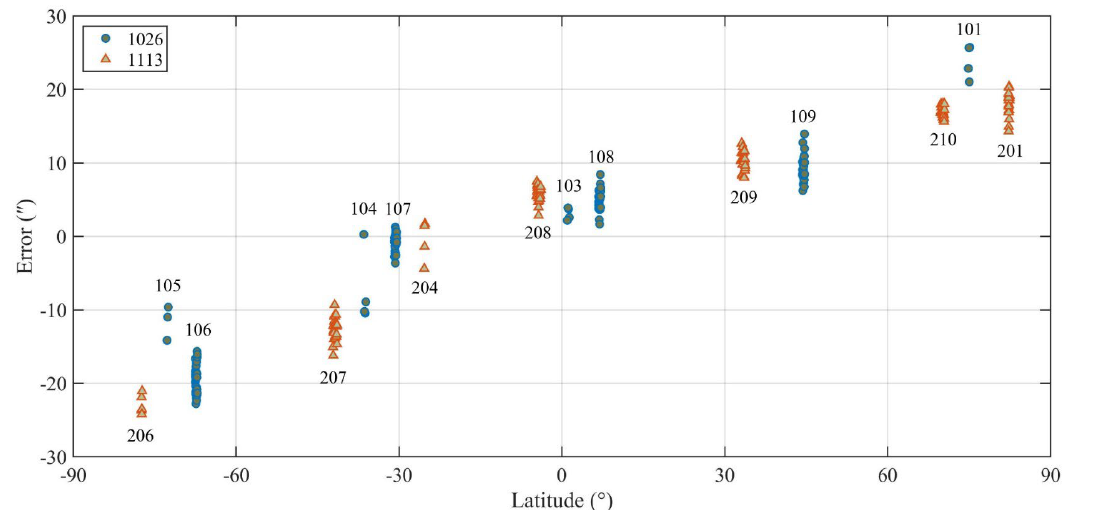
Figure 4 . Angle measurement error of Cam-ST.